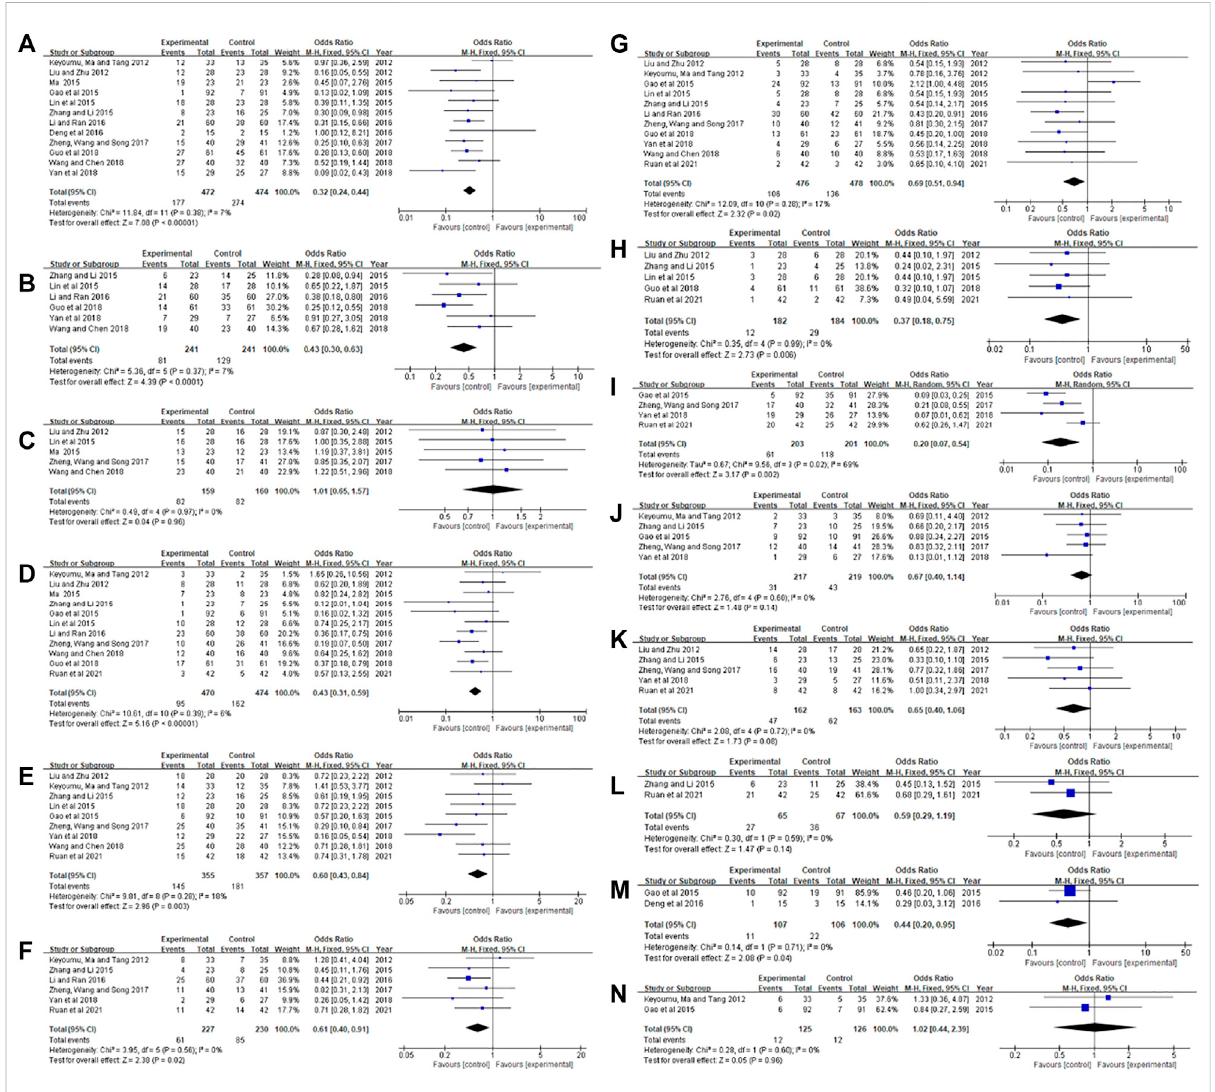
FIGURE 9 Meta-analysis of adverse reactions. (A) Leukopenia; (B) Hand-foot syndrome; (C) Decreased hemoglobin; (D) Thrombocytopenia; (E) Nausea and vomiting; (F) Oral mucositis; (G) Abnormal liver function; (H) Abnormal renal function; (I) Neutrophil decrease; (J) diarrhea; (K) peripheral neurotoxicity; (L) Anemia; (M) Fatigue; (N)